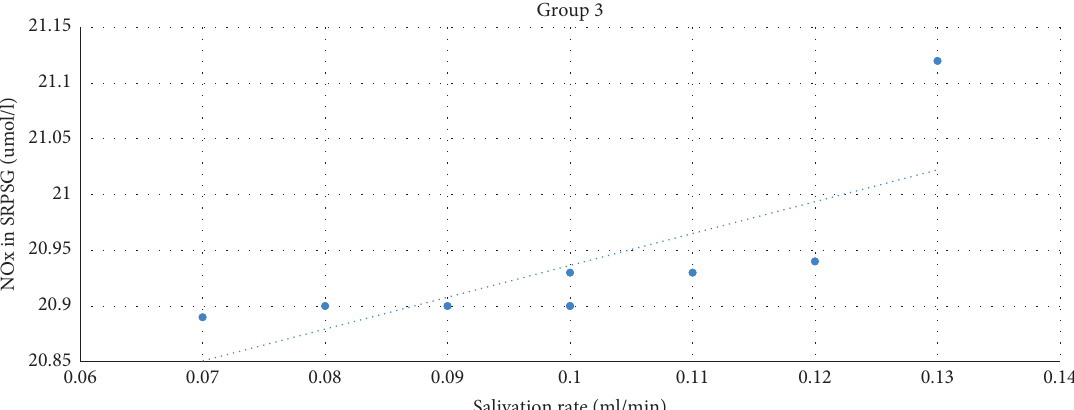
Figure 6: The correlation between the NOx level in SRPSG and the salivation rate among patients in Group 3.